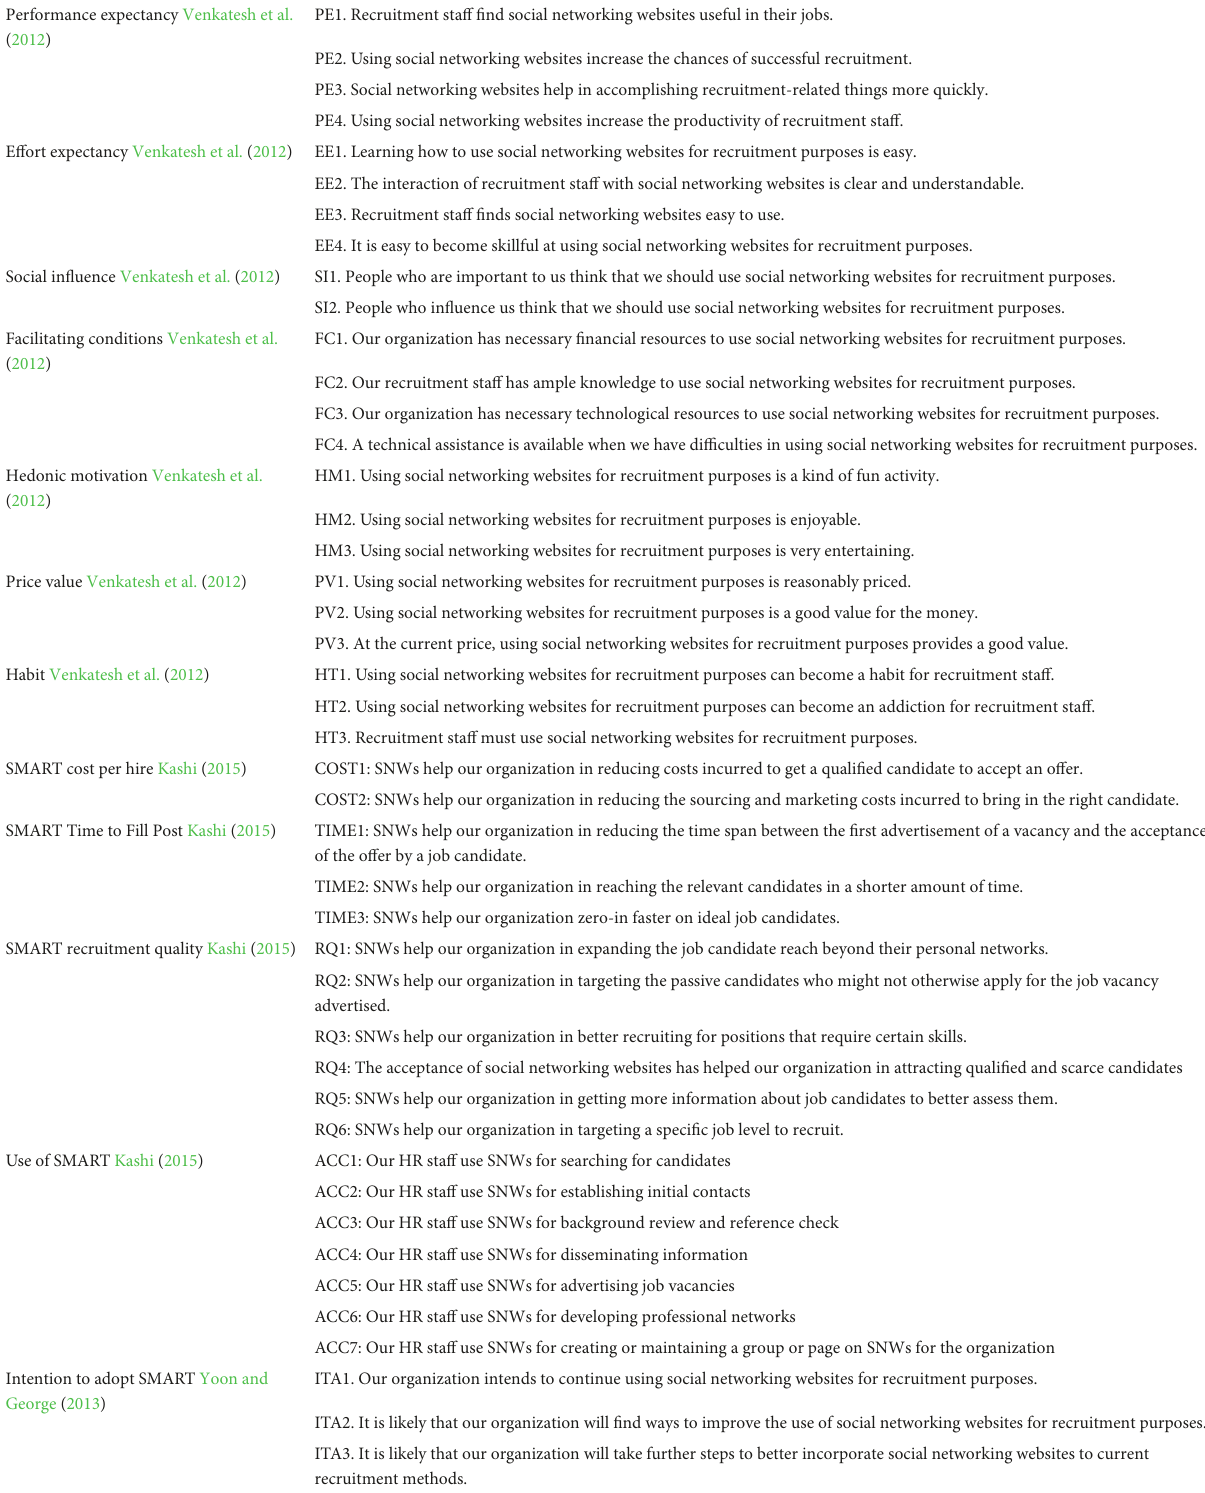
TABLE 2 Constructs and items used in the